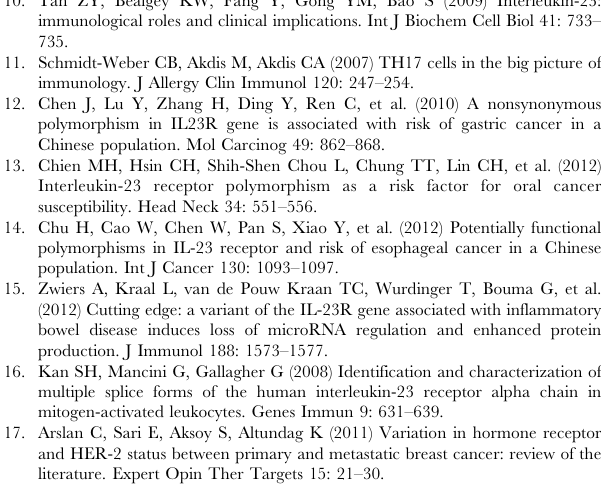
Table S1 Frequency distribution of selected variables in breast cancer cases and cancer-free controls. Table S2 Clinicopathologic description of the breast cancer